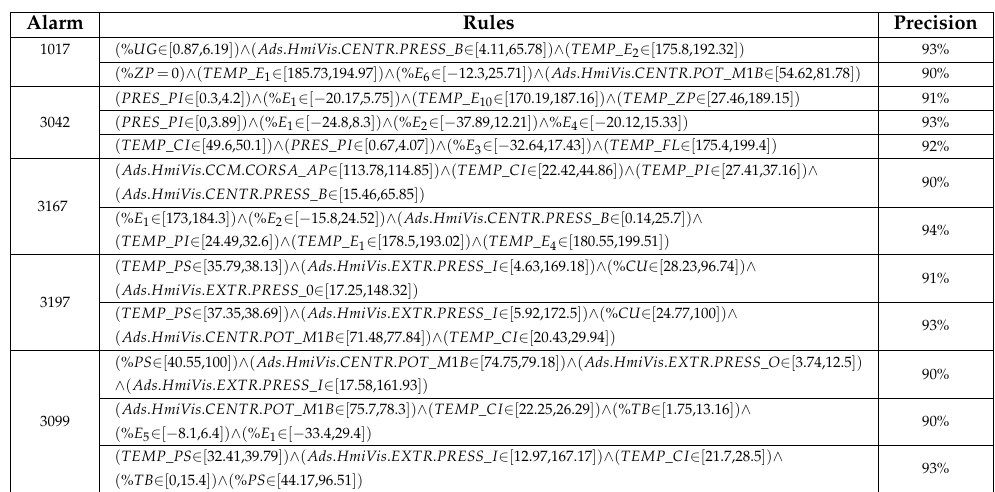
Table 3. Separate-and-Conquer (SeCo) (RUL = 0